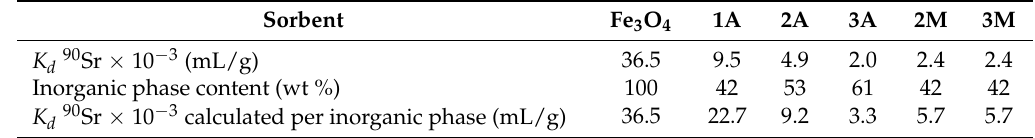
Table 1. Distribution coefficients of 90 Sr for virgin iron oxide and composite materials. Sorbent